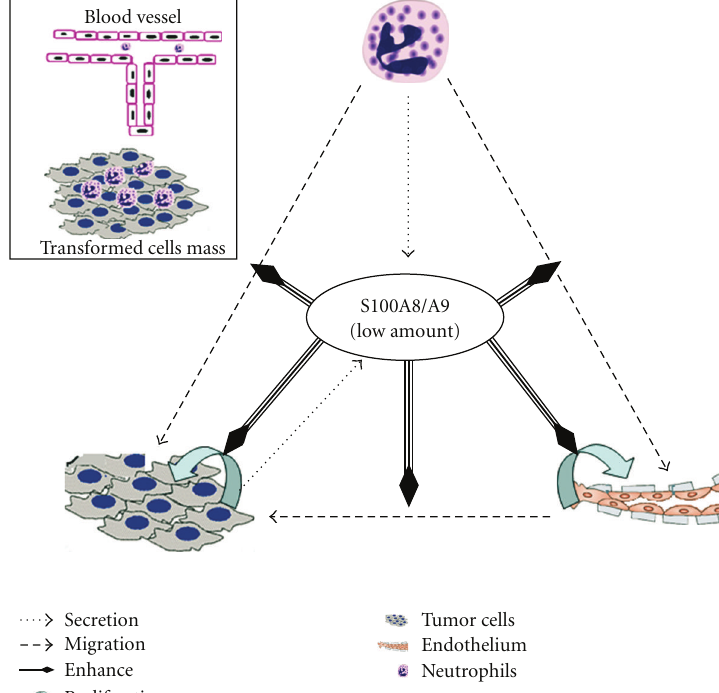
Figure 5: Roles of S100A8/A9 in tumorigenesis. In this hypothesis, S100A8/A9 are produced by newly formed tumor cells or infiltrating leukocytes. When they reach adequately low concentrations, they can stimulate (1) tumor cells proliferation, (2) vascular endothelial cell proliferation, migration, and formation of vascular structures, and (3) neutrophils to migrate into tumor mass or adhere to endothelium. By producing S100A8/A9, the newly entering neutrophils enhance local inflammation and neovascularization in turn. Other S100A family members like S100A4, S100A7, and S100A13 may join S100A8 and/or S100A9 in this episode as